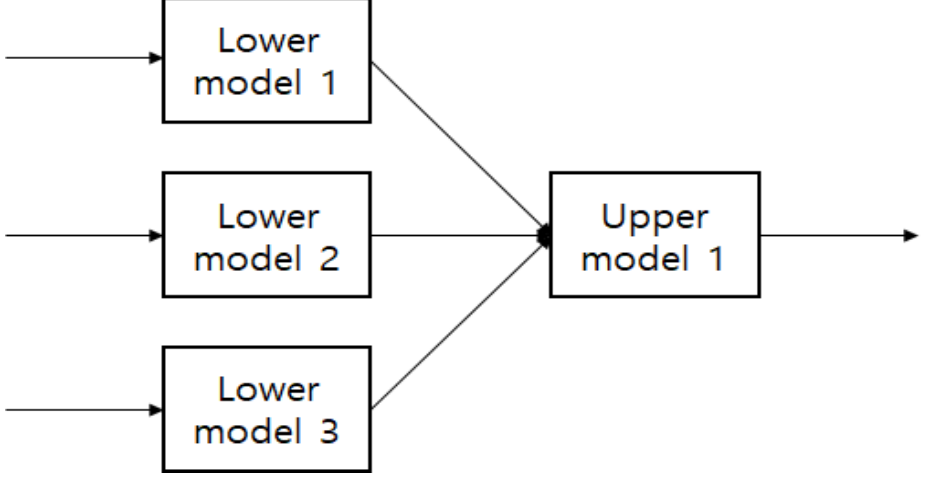
Figure 11. Granular model with a hierarchical structure.